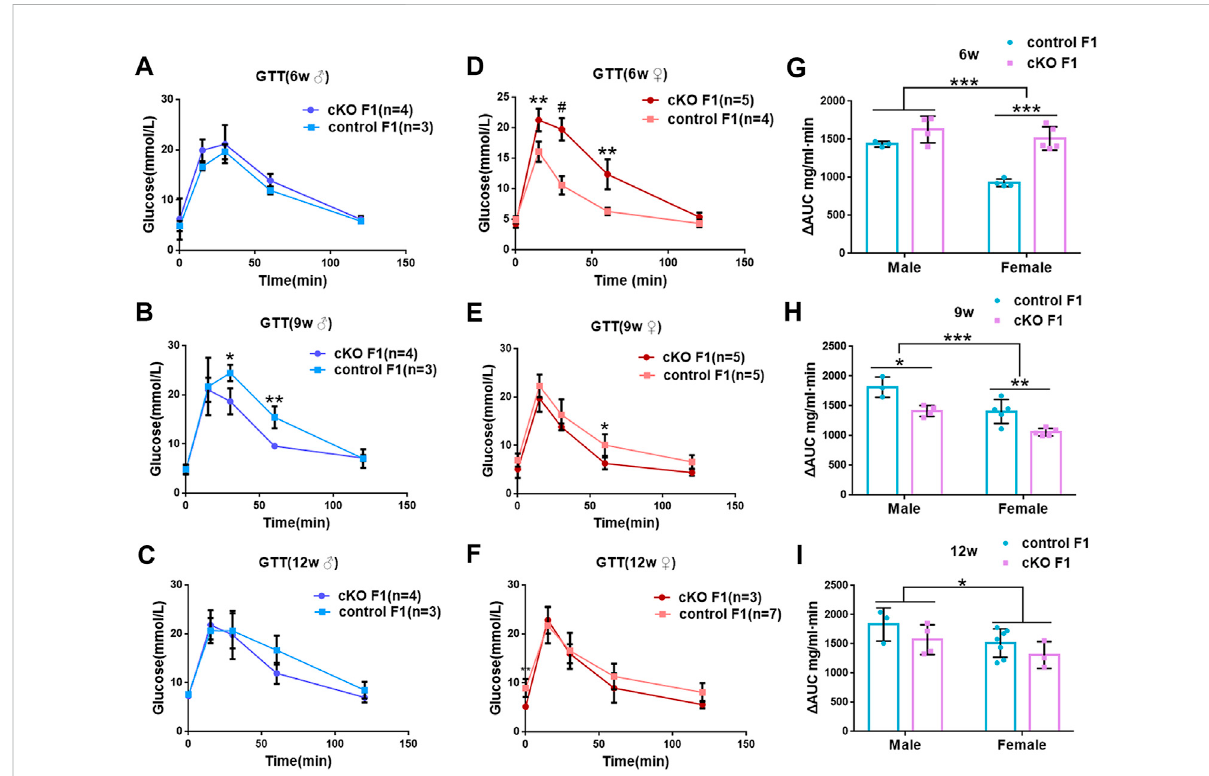
FIGURE 3 Glucose tolerance was measured by GTT in the male and female F1 generation of control and cKO female mice (A – C) Glucose tolerance in control and cKO F1 male mice was measured at 6-weeks, 9-weeks and 12-weeks of age (n = 3 – 4). (D – F) Glucose tolerance in control and cKO F1 female mice was measured at 6-weeks, 9-weeks and 12-weeks of age (n = 3 – 7). (G – I) The area under the curve of glucose tolerance in control and cKO F1 male and female mice at 6-weeks, 9-weeks and 12-weeks of age. Results are presented as mean ± SEM. * p < 0.05, ** p < 0.01, *** and # p < 0.001. GTT, glucose tolerance test. AUC, the area under the